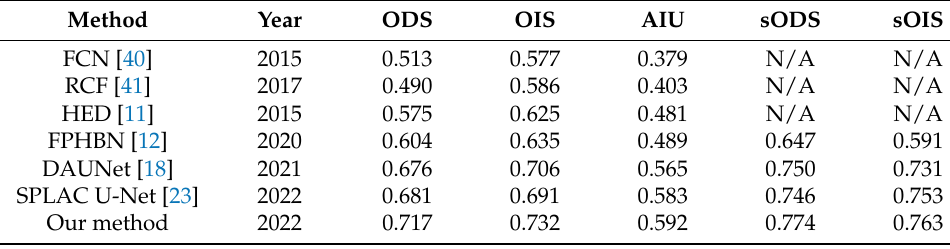
Table 3. Segmentation performance comparison results on Crack500 dataset.